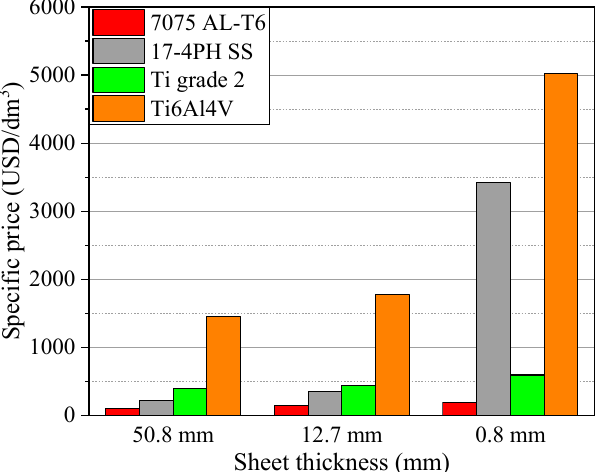
Figure 1. Speci fi c price (USD/dm 3 ) of di ff erent metal sheets (304 × 304 mm) at di ff erent thickness. Figure 1. Specific price (USD/dm 3 ) of different metal sheets (304 × 304 mm) at different